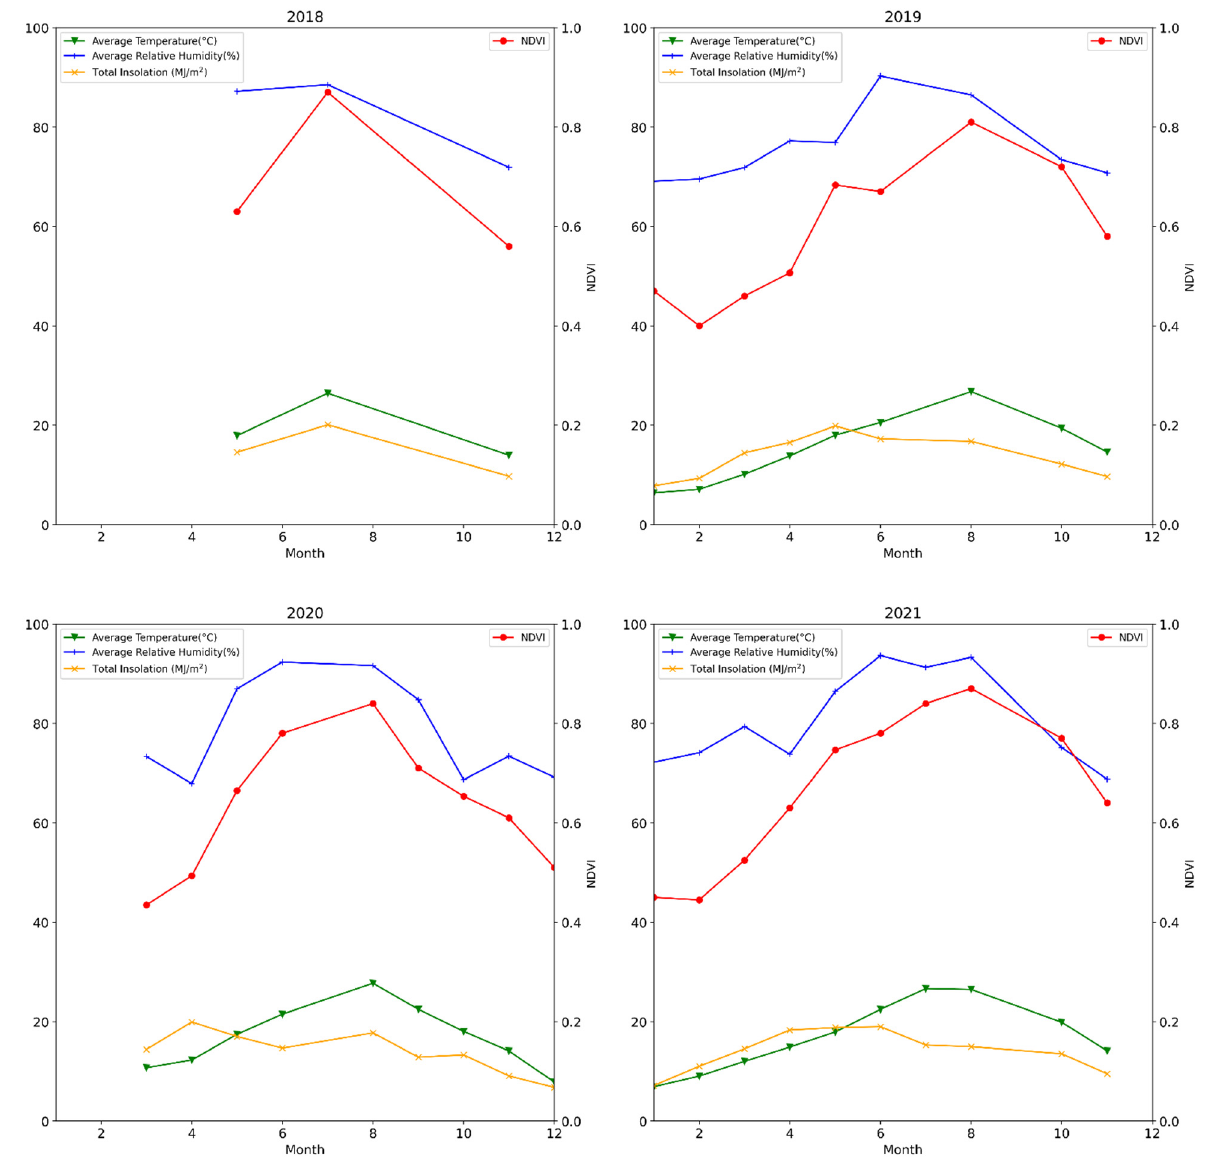
Figure 4. Graphs of Geum-oreum meteorological parameters and NDVI from 2018 to 2021. NDVI, y -axis; time, x -axis; green line, average temperature; blue line, average relative humidity; yellow line, total insolation.